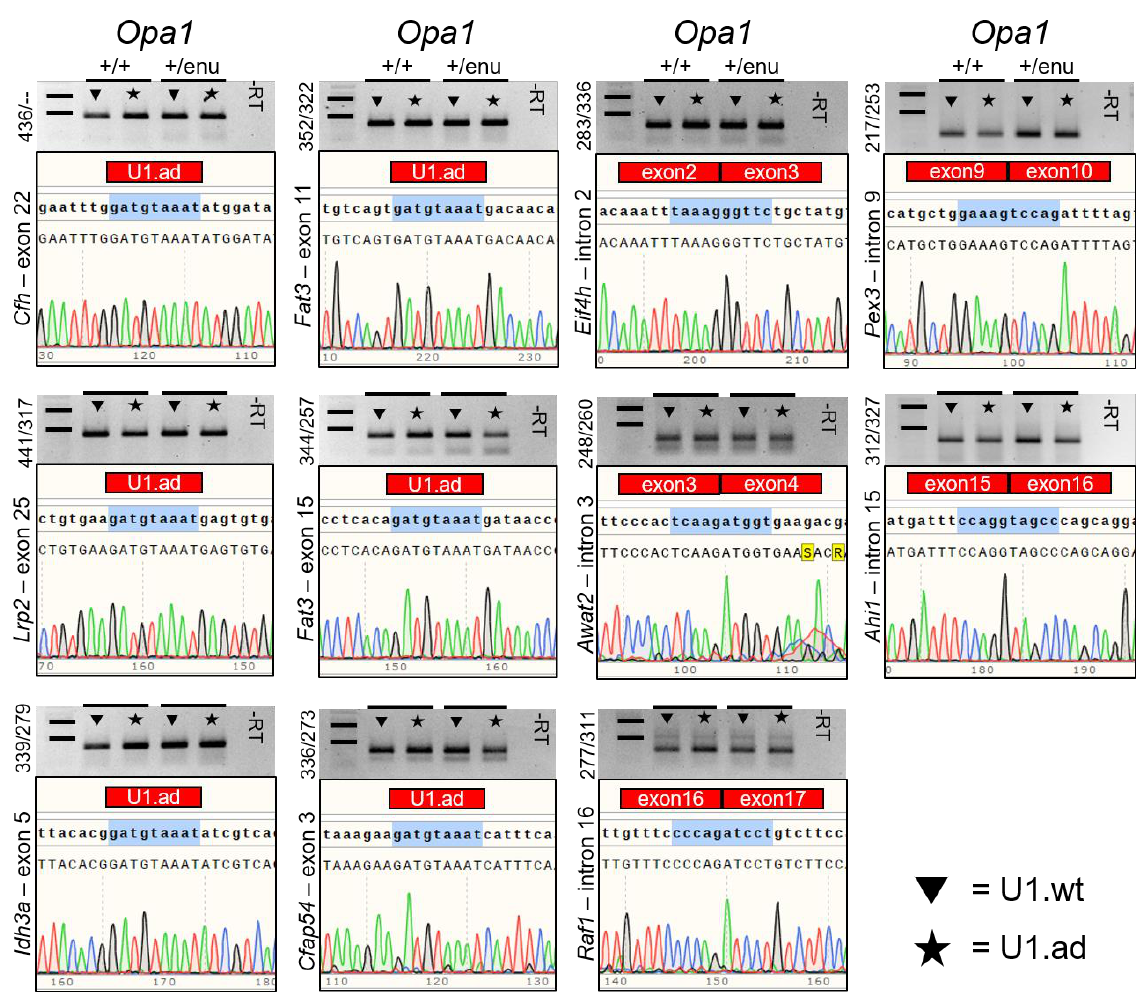
Figure 3. Off-target analyses of engineered U1 on pre-mRNA splicing. Potential off-target transcripts from 11 genes previously associated with retinal phenotypes were analyzed by RT-PCR using exon/intron-spanning primers. Off-target effects on splicing were not detected. Additional bands, indicating splice alterations, were not identified in any of the 11 transcripts upon U1-based treatments, neither in wild-type ( Opa1 +/+ , n = 5) nor in heterozygous ( Opa1 enu/+ , n = 5) mice. Sequencing of the RT-PCR fragments confirmed correct splicing of the potential off-target genes. U1.ad marks potential binding sites of engineered U1. Exon to exon borders are highlighted. Size marker represent 500 and 1000 base pairs (bp). Numbers to the left of each gel image indicate the expected wild-type fragment sizes (first number) as well as sizes of potential off-target splicing events (second